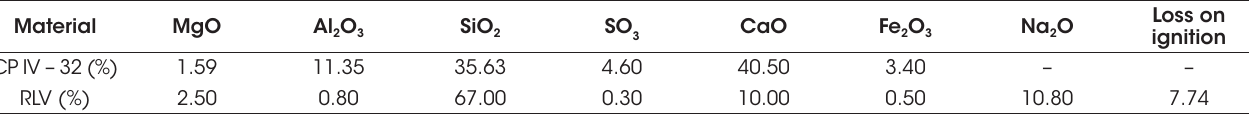
Chemical compositions of CP IV-32 and